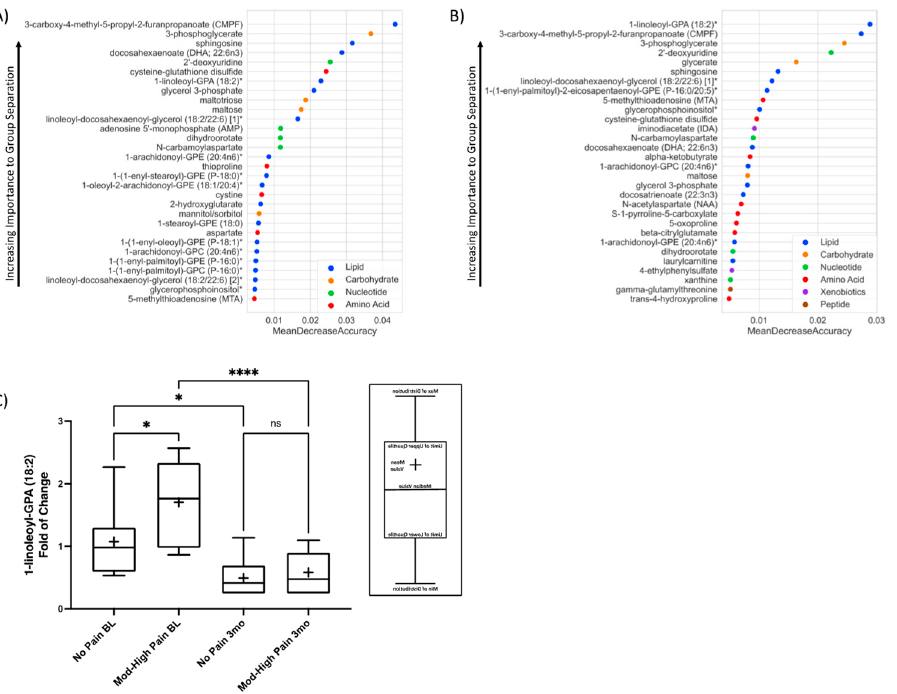
Figure 2. RF classification of plasma samples collected at baseline and 3-months after omega-3 PUFA supplementation. ( A ) Classification of all participants’, regardless of pain status, metabolites were 93% accurate for samples. Top factors contributing to group separation shown in the biochemical importance plot. ( B ) Classification of all participants’, who reported pain symptoms, metabolites were 92% accurate for samples. ( C ) A one-way ANOVA revealed that there was a statistically significant difference in mean 1-linoleoyl-GPA (18:2) relative plasma levels (fold change) between at least two groups (F(3, 42) = (14.63), p ≤ 0.0001). Bonferroni’s post hoc analyses showed significant 1-linoleoyl-GPA (18:2) metabolite plasma level change when comparing No Pain BL to Mod-High Pain BL groups ( p = 0.0143, 95% C.I. = ( − 1.158, − 0.097)), No Pain BL to No Pain 3mo groups ( p = 0.0220, 95% C.I. = (0.063, 1.100)), and Mod-High Pain BL to Mod-High Pain 3mo ( p ≤ 0.0001, 95% C.I. = [0.578, 1.66]). * p ≤ 0.05 and **** p ≤ 0.0001.